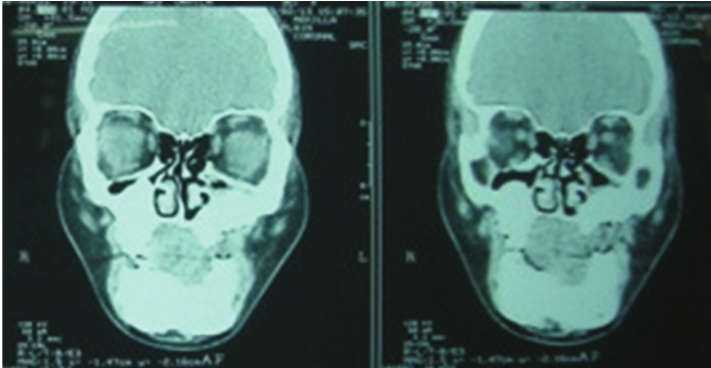
Figure 13: CT scan of patient’s mother (Case 2).